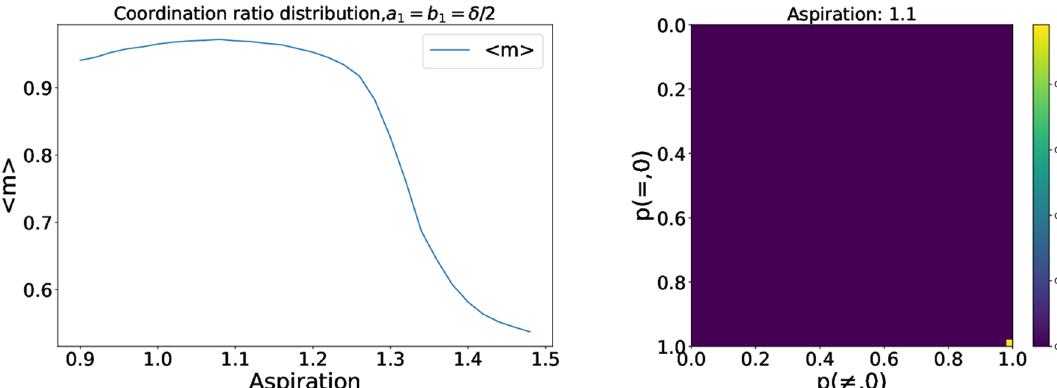
Figure 4. Evolution of the average ratio of coordination for the asymmetric coordination problem with a 1 = b 1 = δ/ 2 (left) for different aspiration levels, and 2D histograms for the probability vectors of the population (right) for A i = 1.1